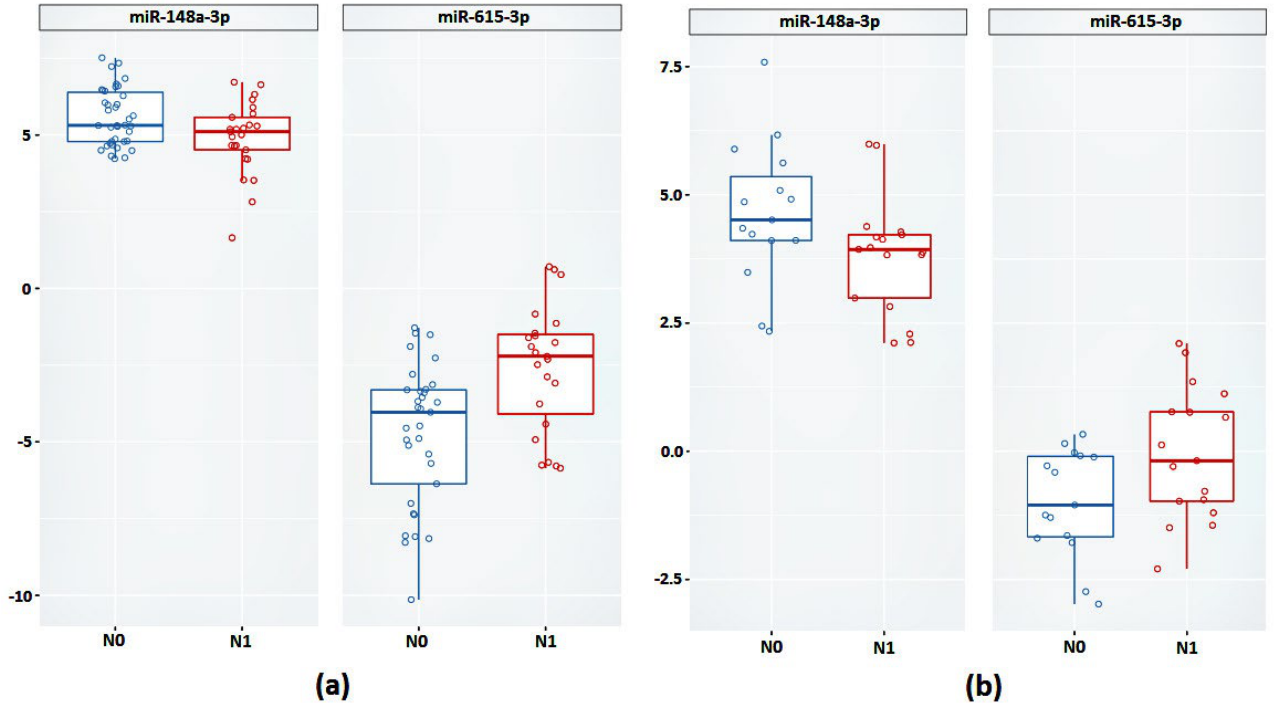
Figure 4. Relative expression of miR-148a-3p and miR-615-3p between groups N0 and N1 ( a ) on FFT samples ( b ) on FFPE samples. samples ( b ) on FFPE